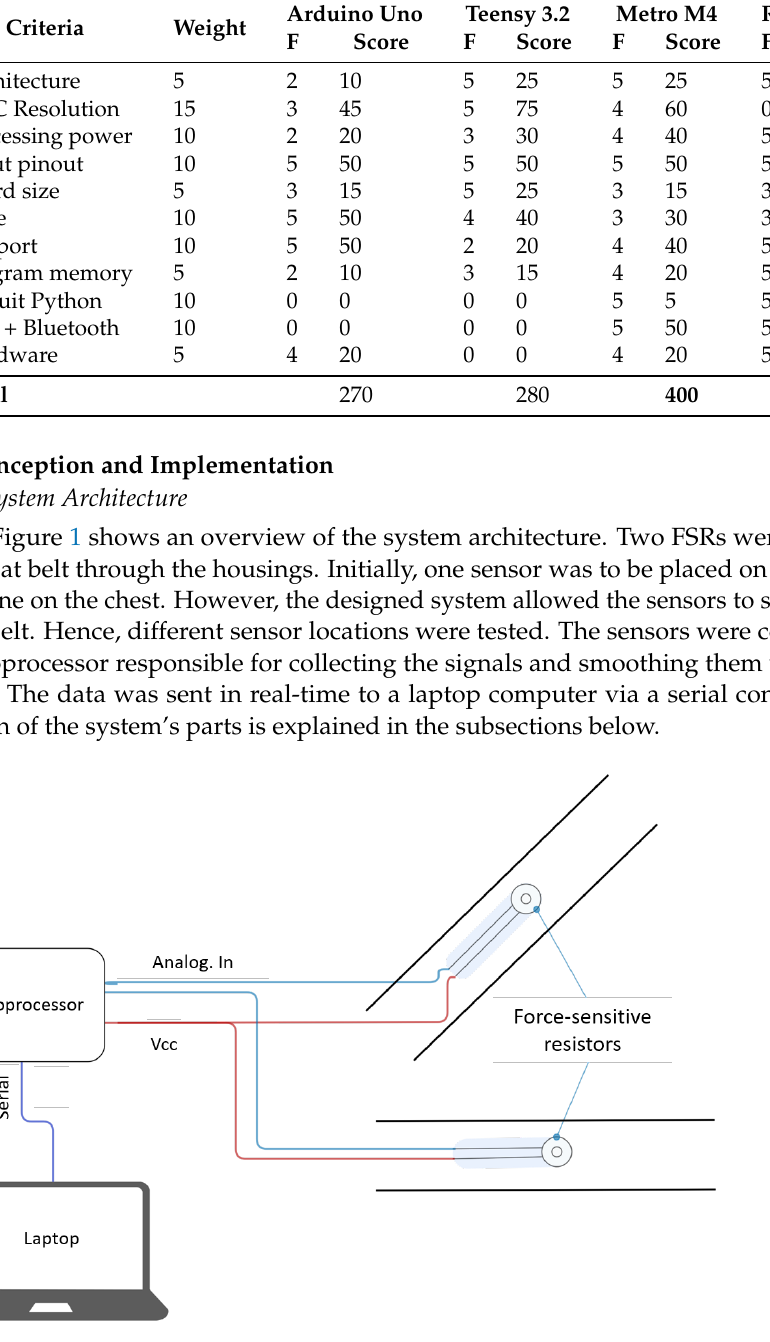
Figure 1. Illustration of the system